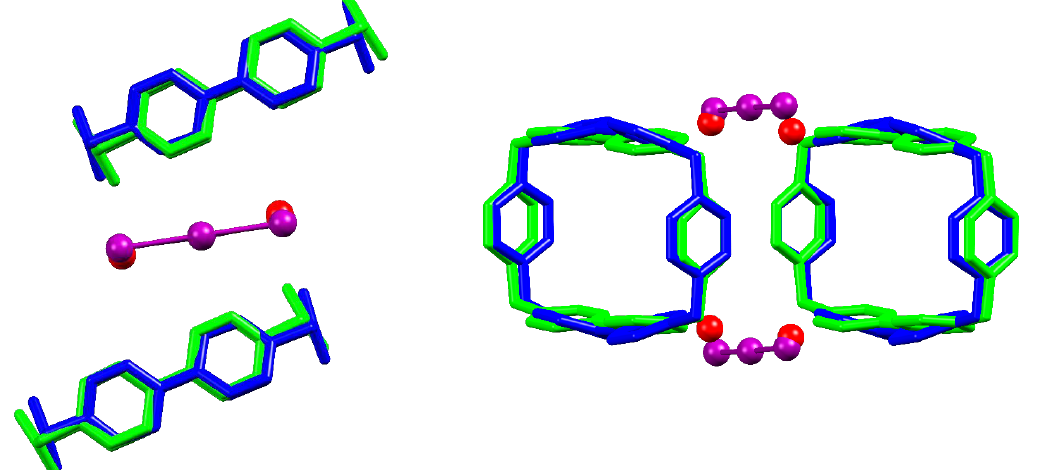
Figure 3. Side and top view of I 3 @BB(I 3 ) 3 · 2DMSO structure (in blue and violet (I 3 − )) superimposed to (ACN) 2 @(BB)I 4 (in green and red (I − )). Superimposition obtained by overlap of the eight C atoms of BB methylenic corners (RMS = 0.383).